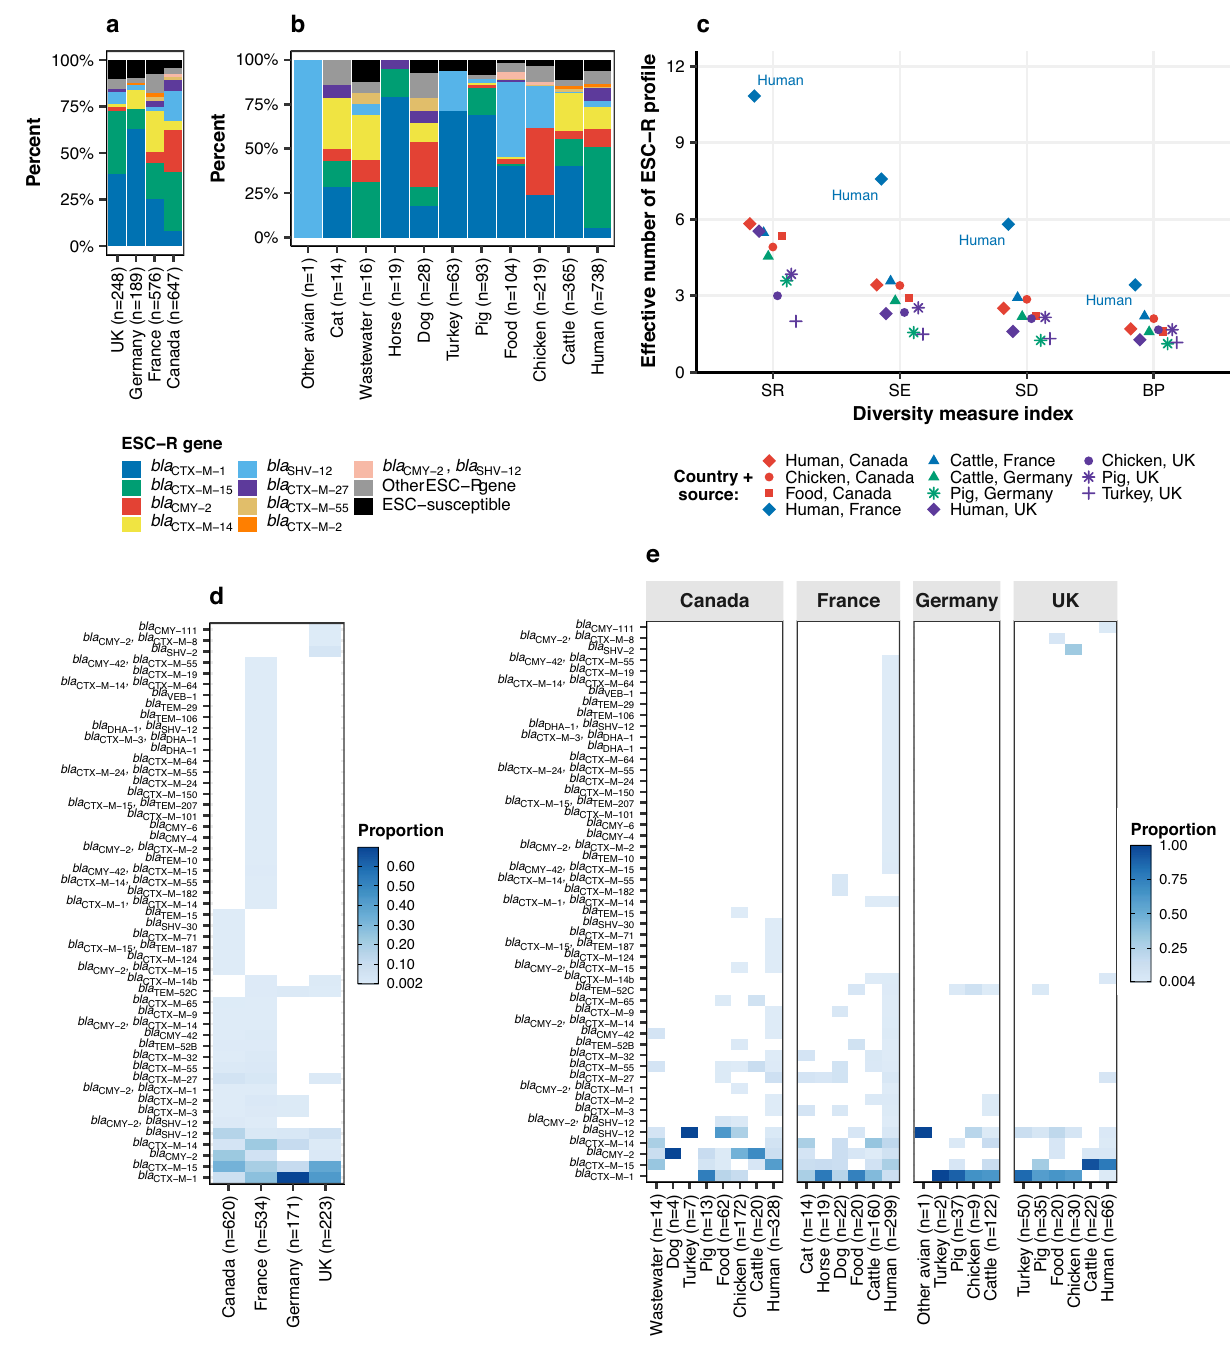
Fig. 1| Frequency anddiversity ofESC-Rgenesin E.coli bycountry andsource. a Percentage of ESC-R gene by country and b source (total n =1,660 ESC-R+ESC- susceptiblegenomes*). The bars are coloured by ESC-R gene, asshown inthe inset legend. c Diversity indices (SR: species richness; SE Shannon entropy, SD Simpson diversity, and reciprocal BP Berger-Parker) of ESC-R pro fi le by compartment (country+source),where only compartments with minimum sample size of n =30 wereincludedintheanalysis(total n =1361ESC-Rgenomes*).Theshapeofthedots